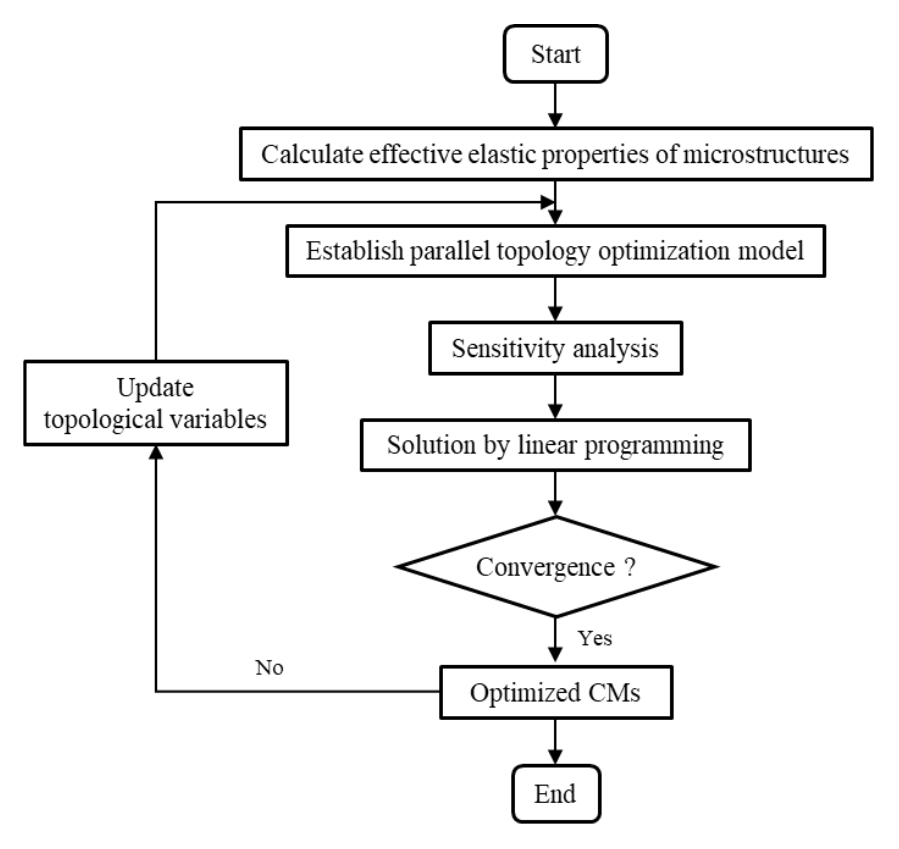
Figure 3. Flow chart of optimization process.